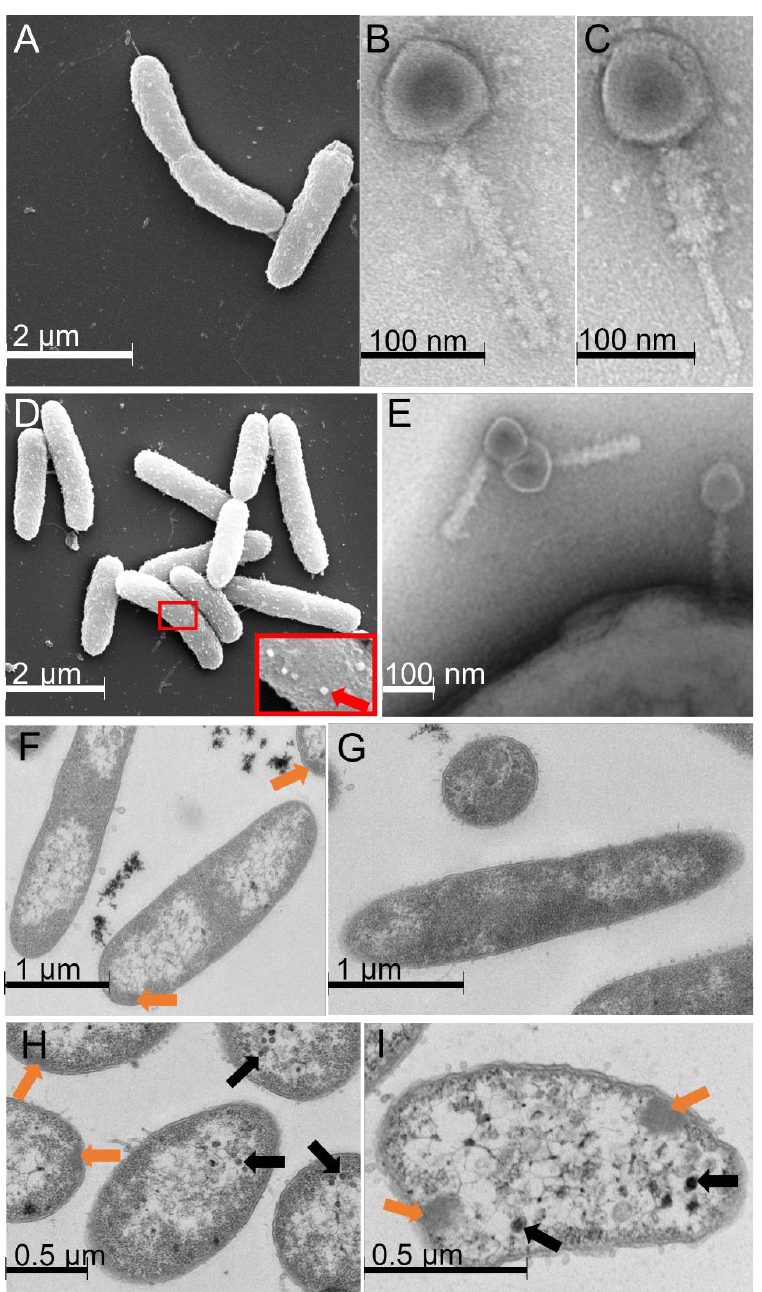
Figure 2. Electron microscopy micrographs of phage 1/4 and its host, Shewanella glacialimarina . SEM micrograph of ( A ) S. glacialimarina and TEM micrographs of phage 1/4 with ( B ) non-contracted